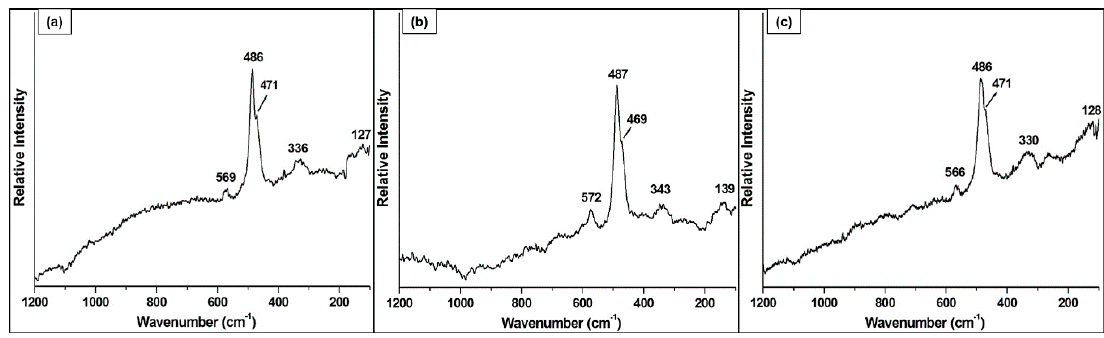
Figure 5. Raman spectra in the 1200–100 cm − 1 range obtained on erionite from ( a ) Oregon, ( b ) Karlik, and ( c ) North Dakota.